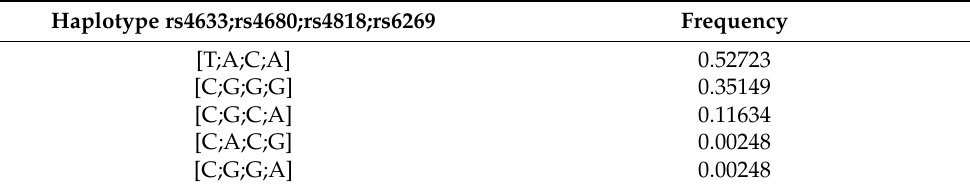
Table 3. Catechol-O-methyltransferase ( COMT ) haplotype frequencies.